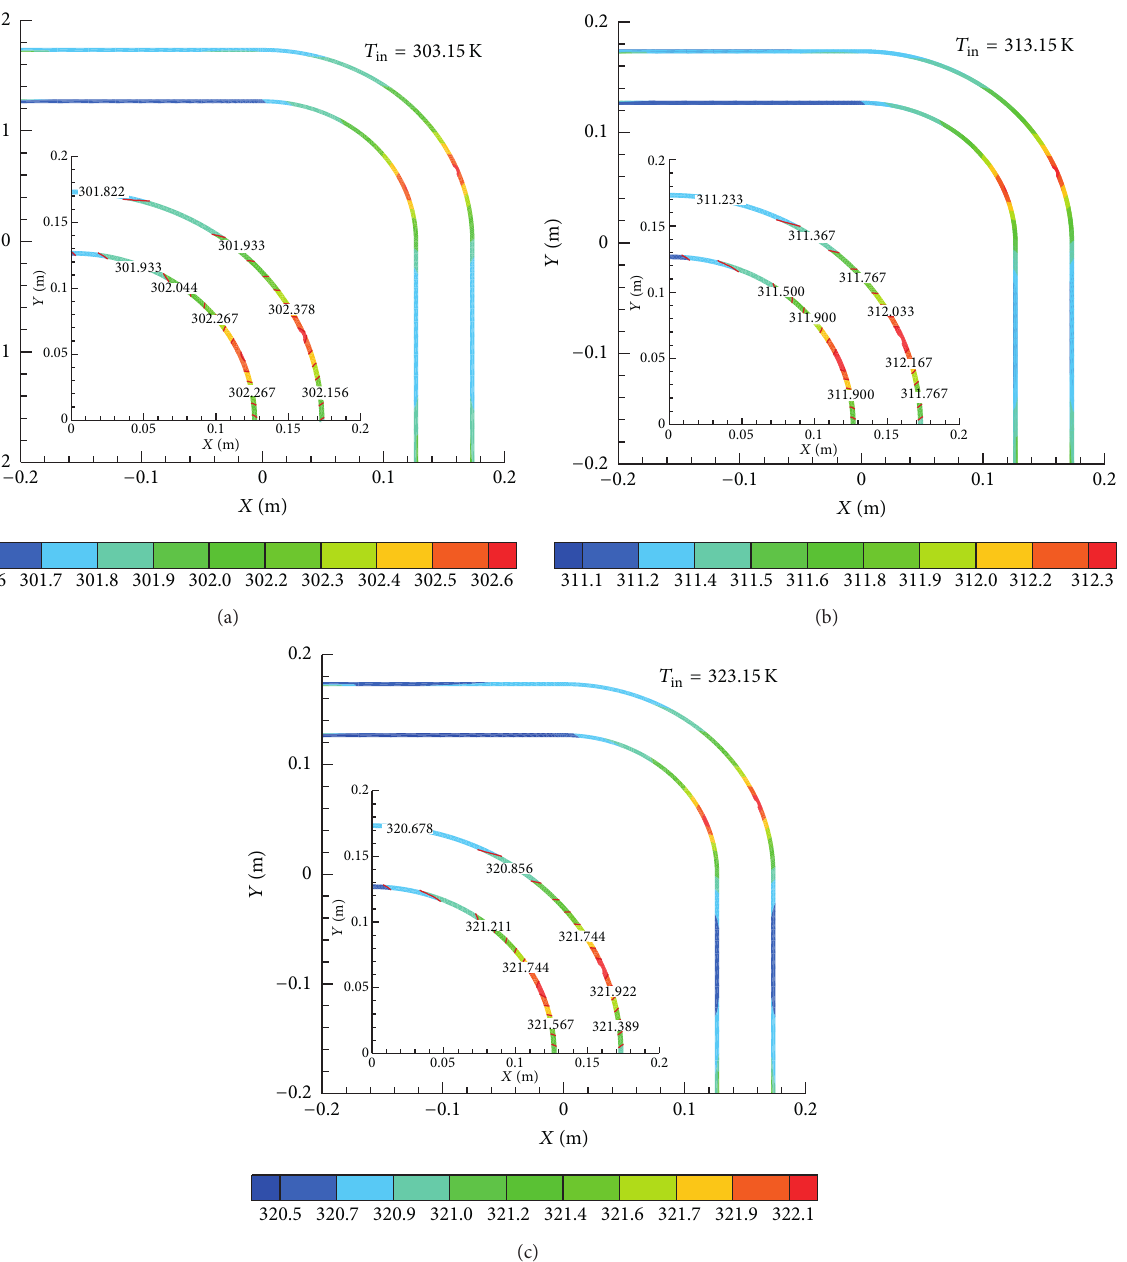
Figure 2: Temperature distribution at the longitudinal cross section of bend pipe at different inlet temperatures.